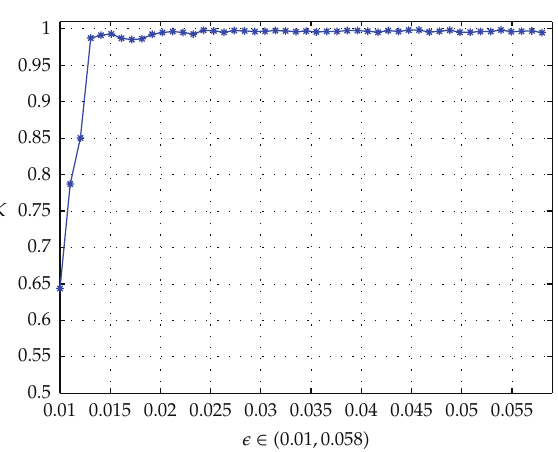
Figure 5: Plot of K versus (cid:2) for the DCML (cid:3) 3.18 (cid:4) with (cid:2) ∈ (cid:3) 0 . 01 , 0 . 058 (cid:4) increased in increments of 0.01. We used 30000 data points of x (cid:3) 111 (cid:4)